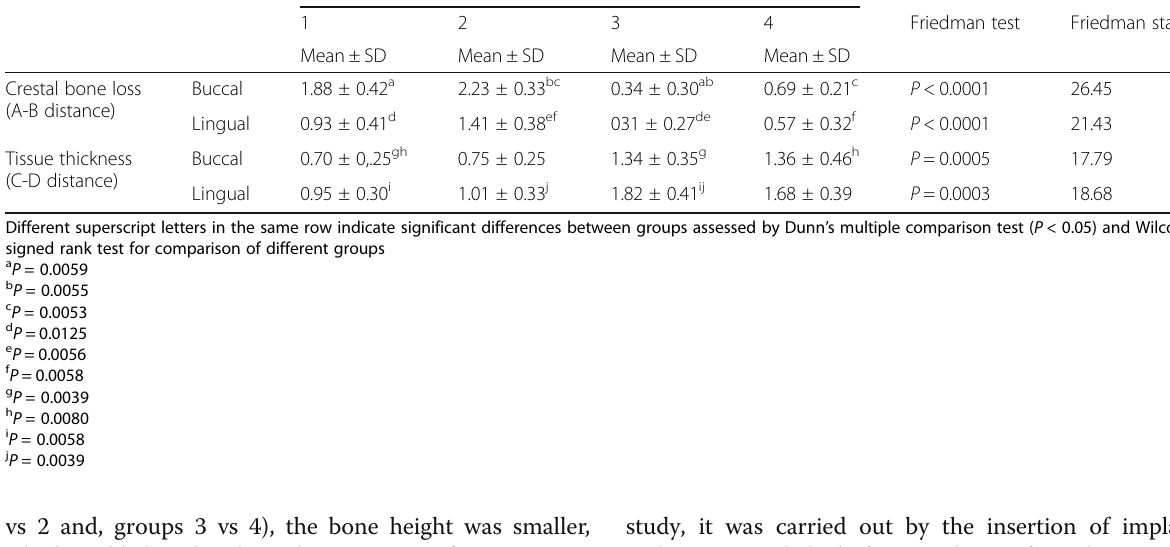
Table 3 Statistical analysis comparing measured distances (A-B and C-D) among different groups in buccal and lingual sites Group